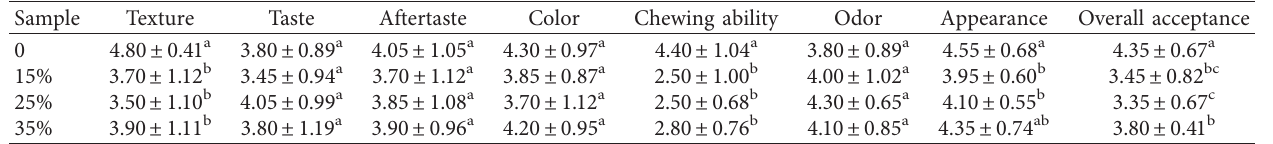
Table 5: Sensory evaluation of sponge cake prepared with different levels of OSP † .